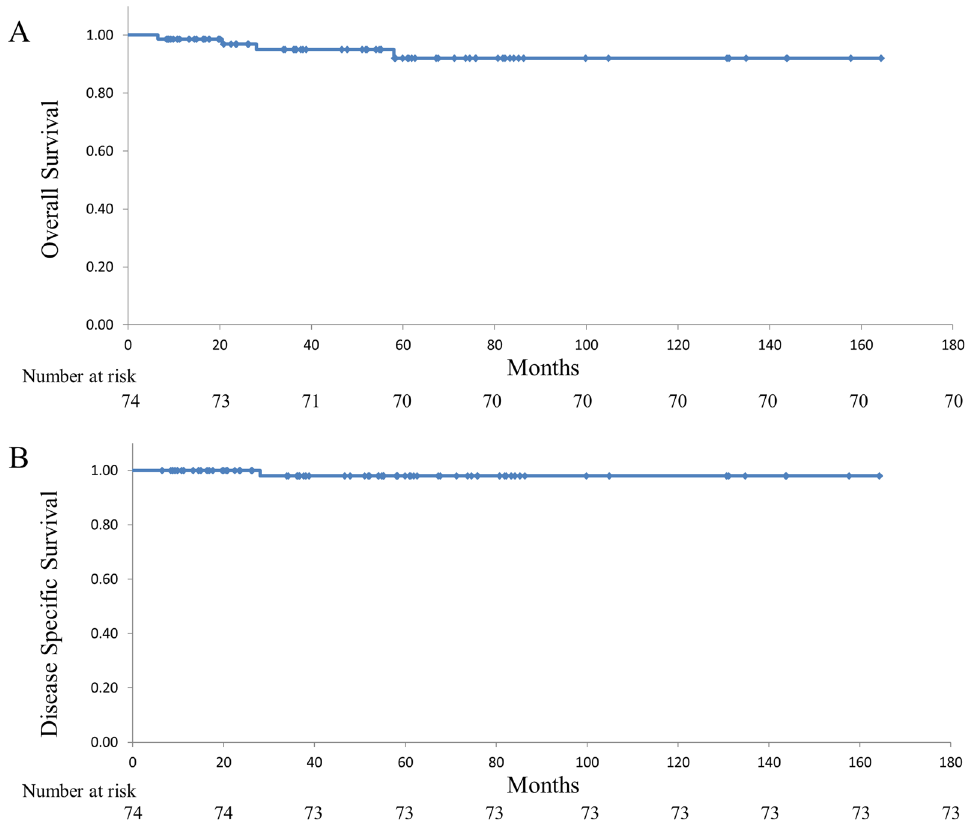
Figure 2. Estimated overall survival ( A ) and disease specific survival ( B ) of patients with an early ampullary